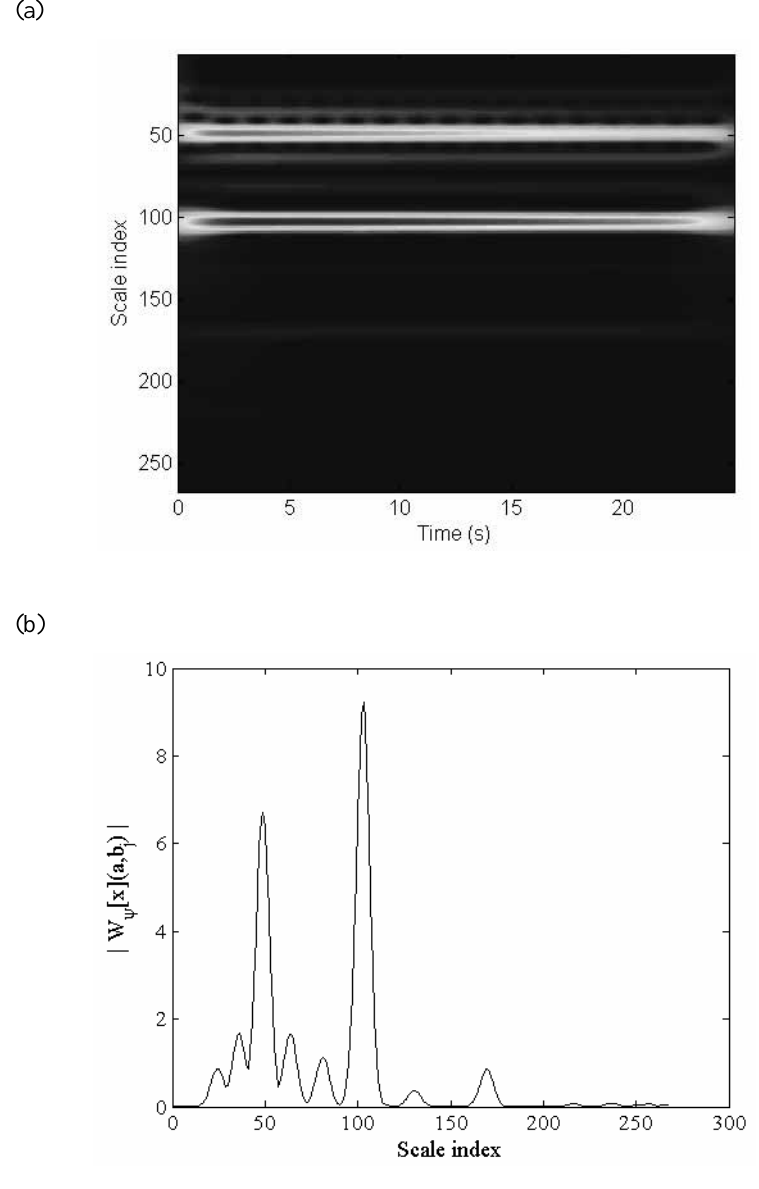
Fig. 7. (a) Wavelet transform amplitude; (b) Determination of dilatation parameters a i